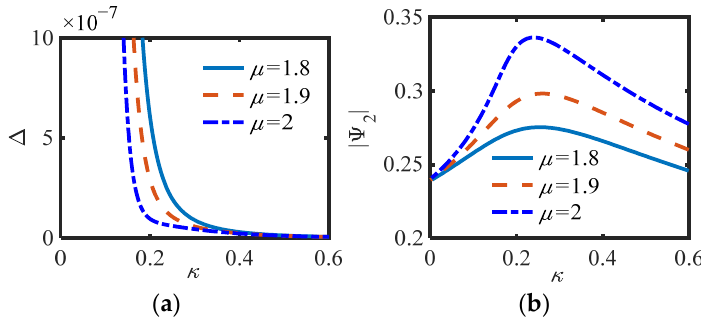
Figure 10. ( a ) Δ and ( b ) | Ψ 2 | of S.2 vs. κ for different μ ( c s = 0.1). Whether in S.1 or S.2, the positive and negative of Δ correspond to the number of equilibrium points of the system one by one, and can also correspond to the positive and negative prediction of Δ 1 or Δ 2 in the previous section. Under the same parameters, the smaller μ , the smaller the amplitude of the equilibrium point, and the less likely it is to switch the number of equilibrium points, indicating that the inertia and damping effects of the inerter exist simultaneously when μ is between 1 and 2. Here, κ 1,2 = (0.22, 0.34) is calculated by substituting the parameters into (20) when μ = 1.8 in Figure 7b, and κ 1,2 = (0.77, 1.26) is calculated by substituting the parameters into (27) when μ = 2 in Figure 9b. Obviously, the calculated results of the two groups of parameters are consistent with the positions of the actual simulation curves. In addition, as predicted in the previous section, it is not easy to produce multiple equations with S.2. Particularly, when Δ 1 = 0 or Δ 2 = 0,